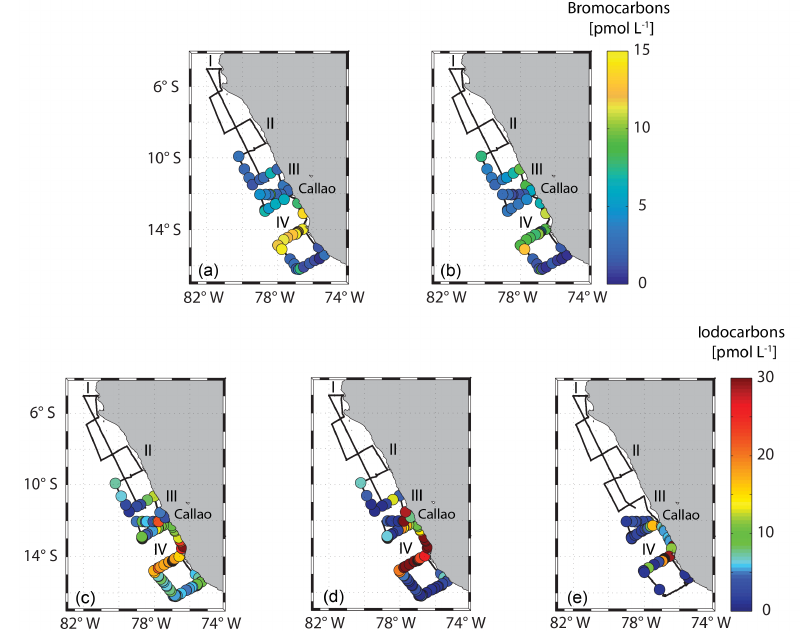
Figure 2. Halocarbon surface water measurements are shown in panels (a) and (b) for the bromocarbons (note the colour bar in the upper panel) with (a) CHBr 3 and (b) CH 2 Br 2 . Iodocarbons can be found in panels (c–e) (note the colour bar in the lower panel) with (c) CH 3 I, (d) CH 2 ClI and (e) CH 2 I 2 .